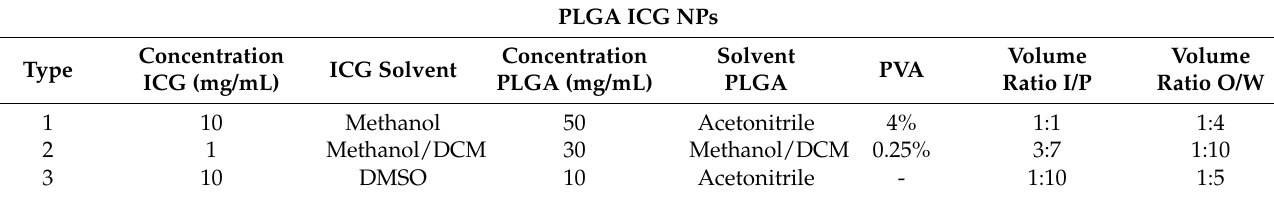
Table 2. Solvents, starting concentrations and volume ratios of PLGA ICG NPs. (I: organic solvent ICG, P: organic solvent PLGA, O: total organic phase, W: total aqueous